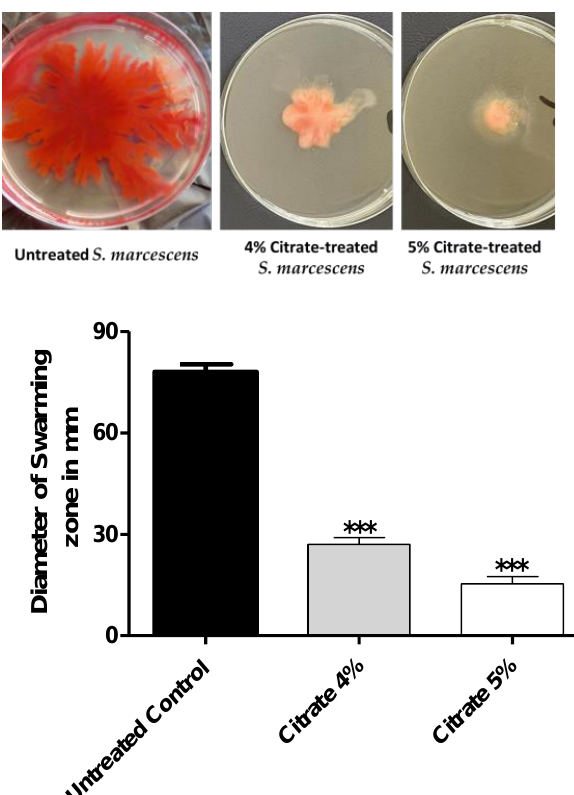
Figure 3. The effect of sodium citrate at 4% or 5% on the S. marcescens swarming motility. Citrate at 4% or 5% significantly decreased the swarming zones of S. marcescens by about 62% or 78%, respectively. The One-way ANOVA test was employed to assess significance; ***: p ≤ 0.001.